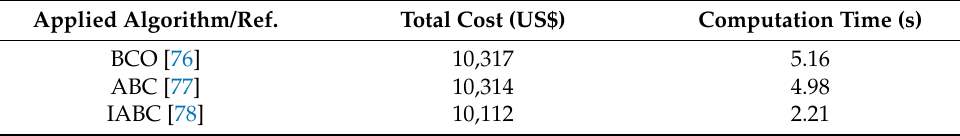
Table 1. The numeric results of the BCO, ABC, and IABC, implemented in a CHPED model *. Applied